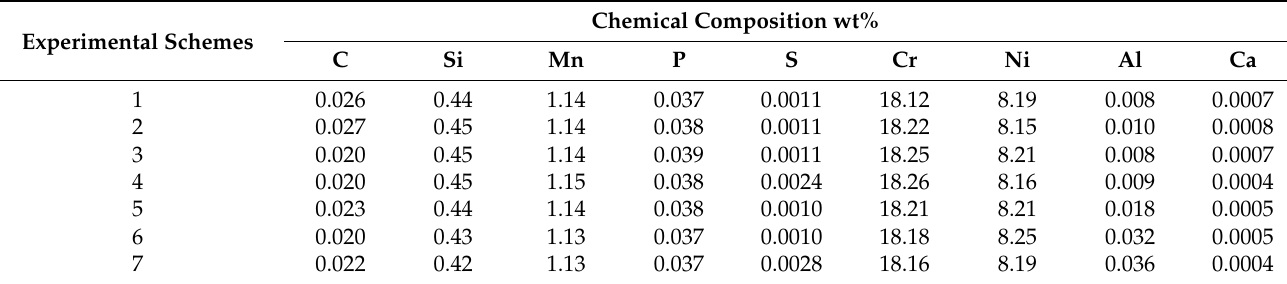
Table 3. Chemical composition of electroslag